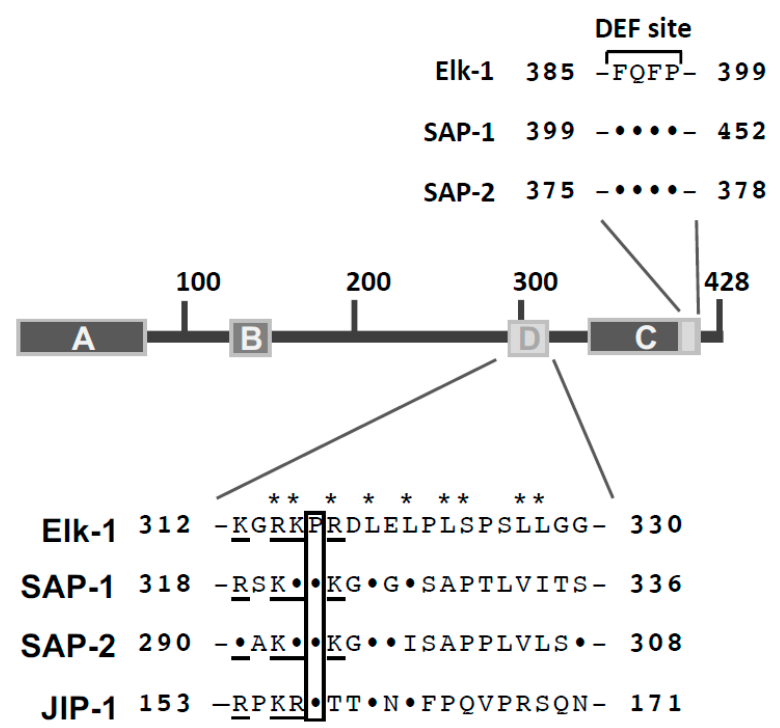
Figure 7. Protein kinase docking sites within the TCF proteins. Amino acid sequence of the D-box (D-domain, D-site) and the DEF site. The sequence information is derived from Ref. [7]. Critical amino acids of Elk-1 required for binding of MAP kinases are marked with stars. The sequence of the JNK docking site to the JNK-interacting protein-1 (JIP-1) is also depicted. The box shows a proline residue present in TCF proteins and JIP-1.